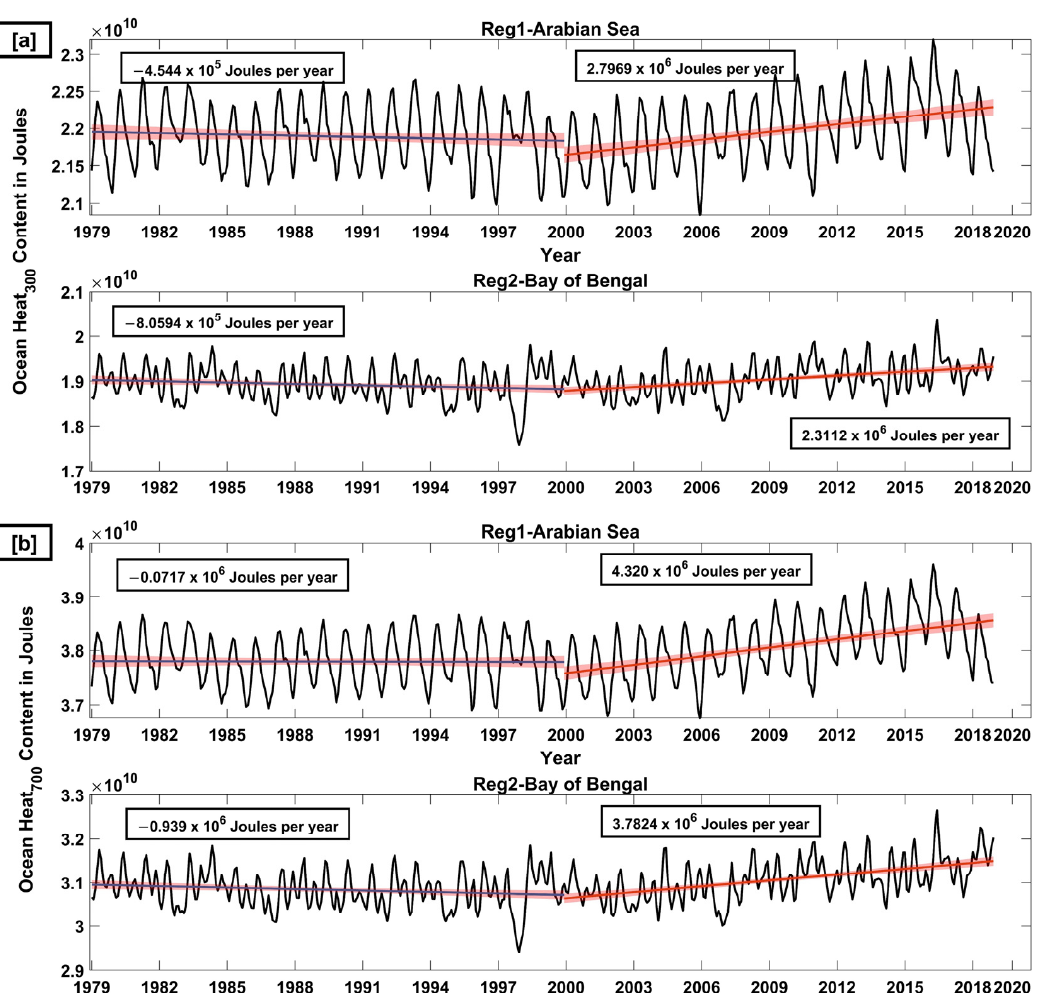
Figure 4. Variability in ORAS5 OHC at ( a ) D300 (top panel) and ( b ) D700 (bottom panel) along with the corresponding confidence interval (red patches) over the Arabian Sea and Bay of Bengal region during the period 1979–2020 (trend analysis separated before and after the year 2000).